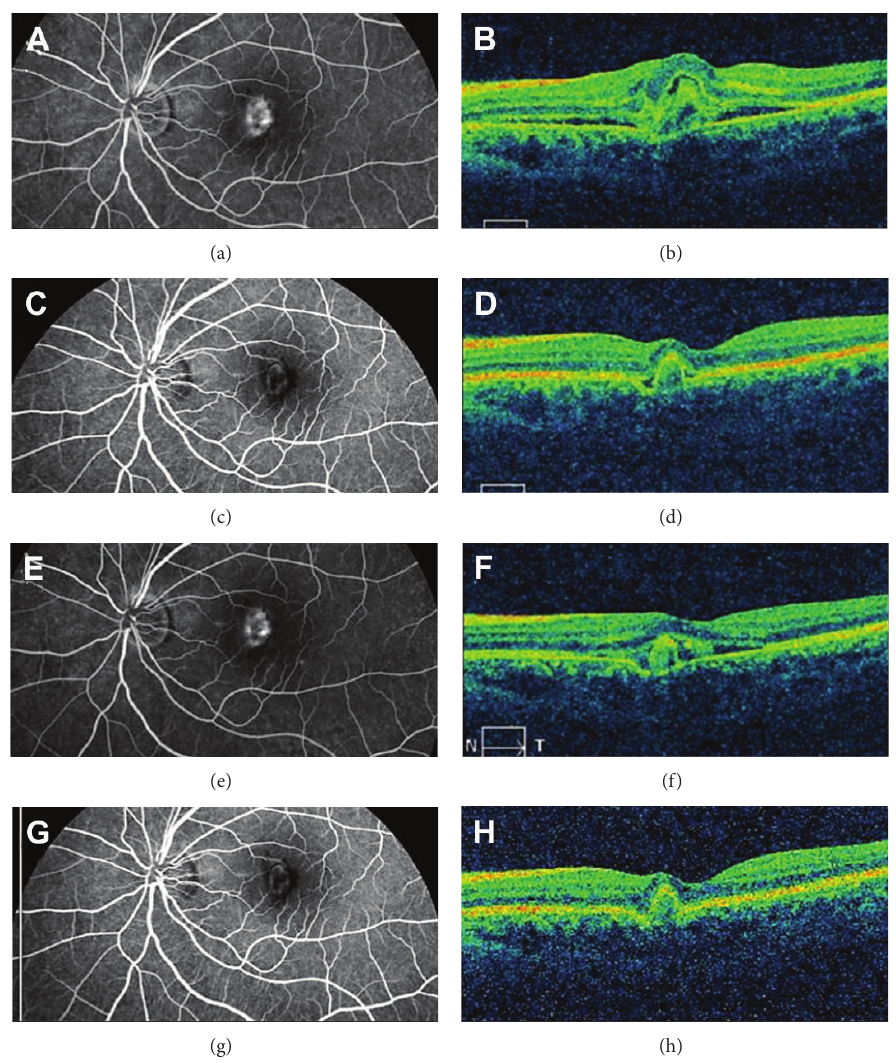
Figure 2: Fluorescein angiography and horizontal optic coherence tomography findings in a patient in the interim group. (a) Fluorescein angiography at late stage and (b) horizontal optic coherence tomography cross-sections of the macula from in the left eye of a 20-year-old woman with subretinal idiopathic choroidal neovascularization, subretinal fluid, and intraretinal edema. Her BCVA was 44 letters at baseline. Three months later, the BCVA was 54 letters, and subretinal fluid had reduced (c). The retinal pigment epithelium had also become smaller (d). Six months after the injection, compared to the conditions at 3 months after injection, fluorescein leakage appeared again (e), subretinal fluid increased (f), and BCVA was 49 letters. Therefore, the 2nd injection was administered. At 12 months, the BCVA was 57 letters, subretinal fluid had disappeared (g), and the retinal profile was normal except for minimally elevated retinal pigment epithelium (h).